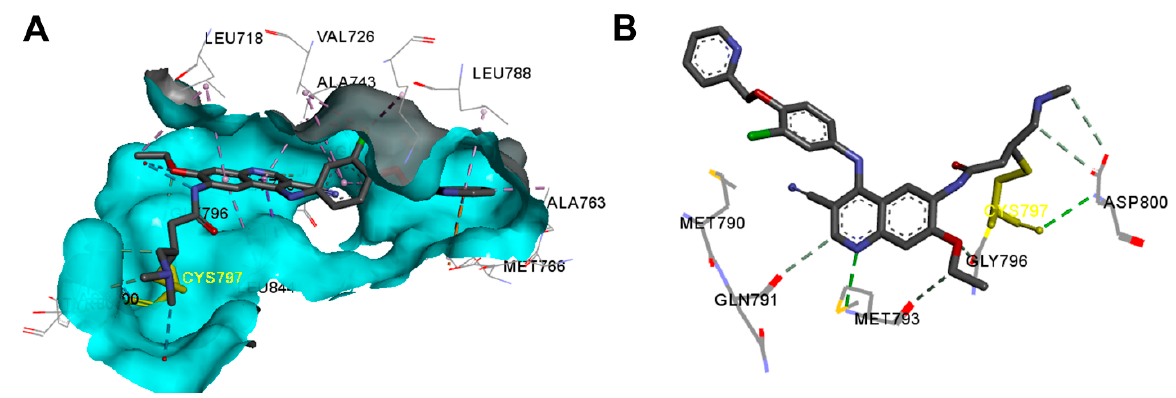
Figure 46. Binding modes of neratinib (shown as sticks) into EGFR kinase domain T790M/L858R mutant (pdb: 3W2Q): ( A ) 3D binding mode, receptor shown as hydrogen bond surface; ( B ) 2D binding mode showing the covalent bond with Cys797 (yellow sticks) and the hydrogen bond interactions; the figure was generated using Discovery Studio Visualizer (V16.1.0.15350).